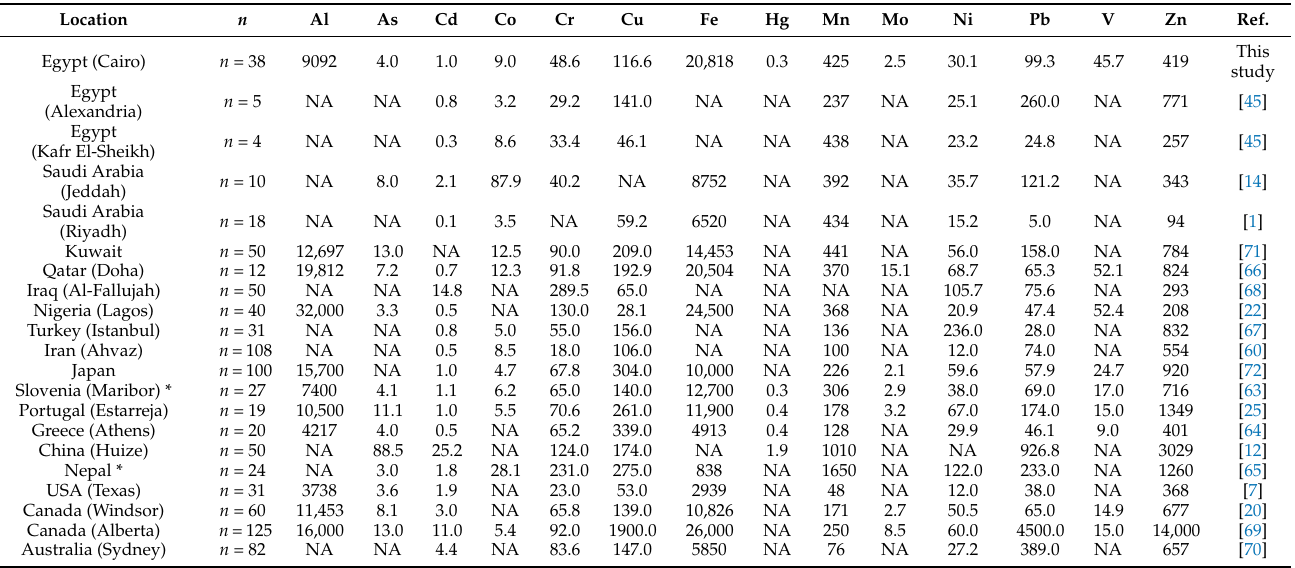
Table 3. Comparison between PTE concentrations in the household dust in Cairo City with those for indoor dust in other cities